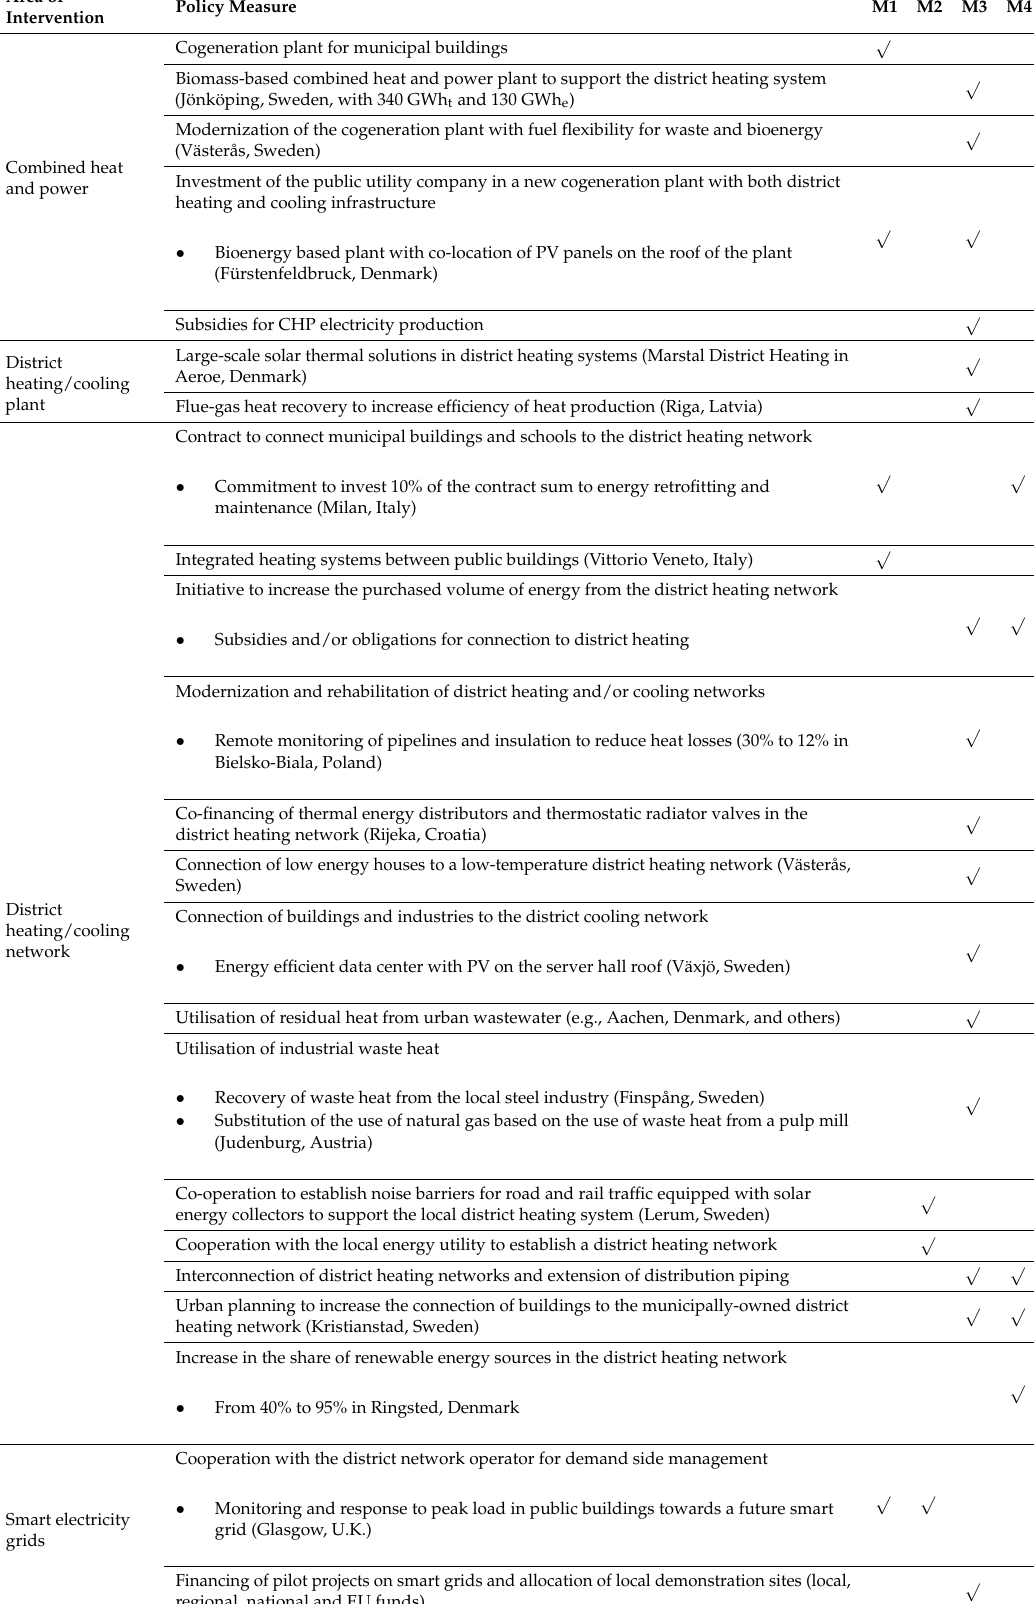
Table A2. Combined heat and power, district heating and cooling and smart grids. Area of